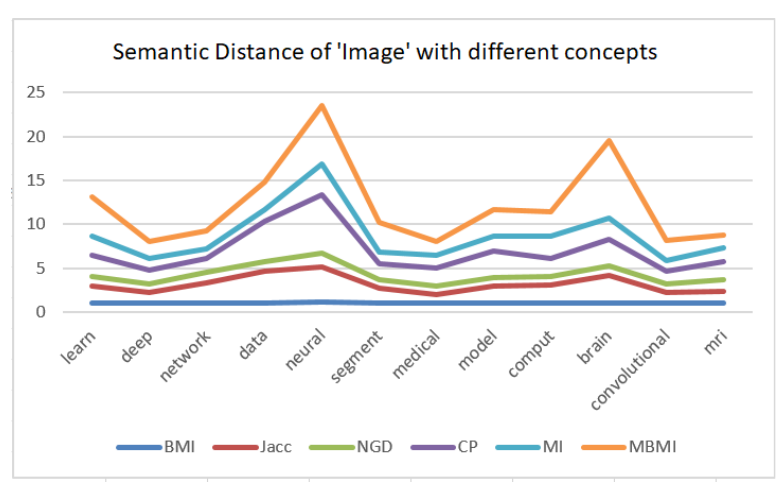
Figure 10. Semantic Distance of term “Image” with cross domain terms using different techniques